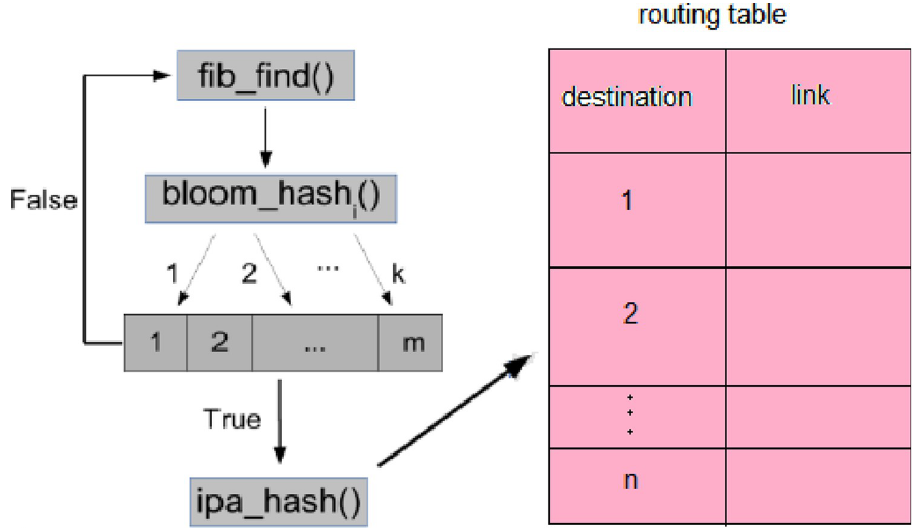
Fig 7. Proposed bloom filter